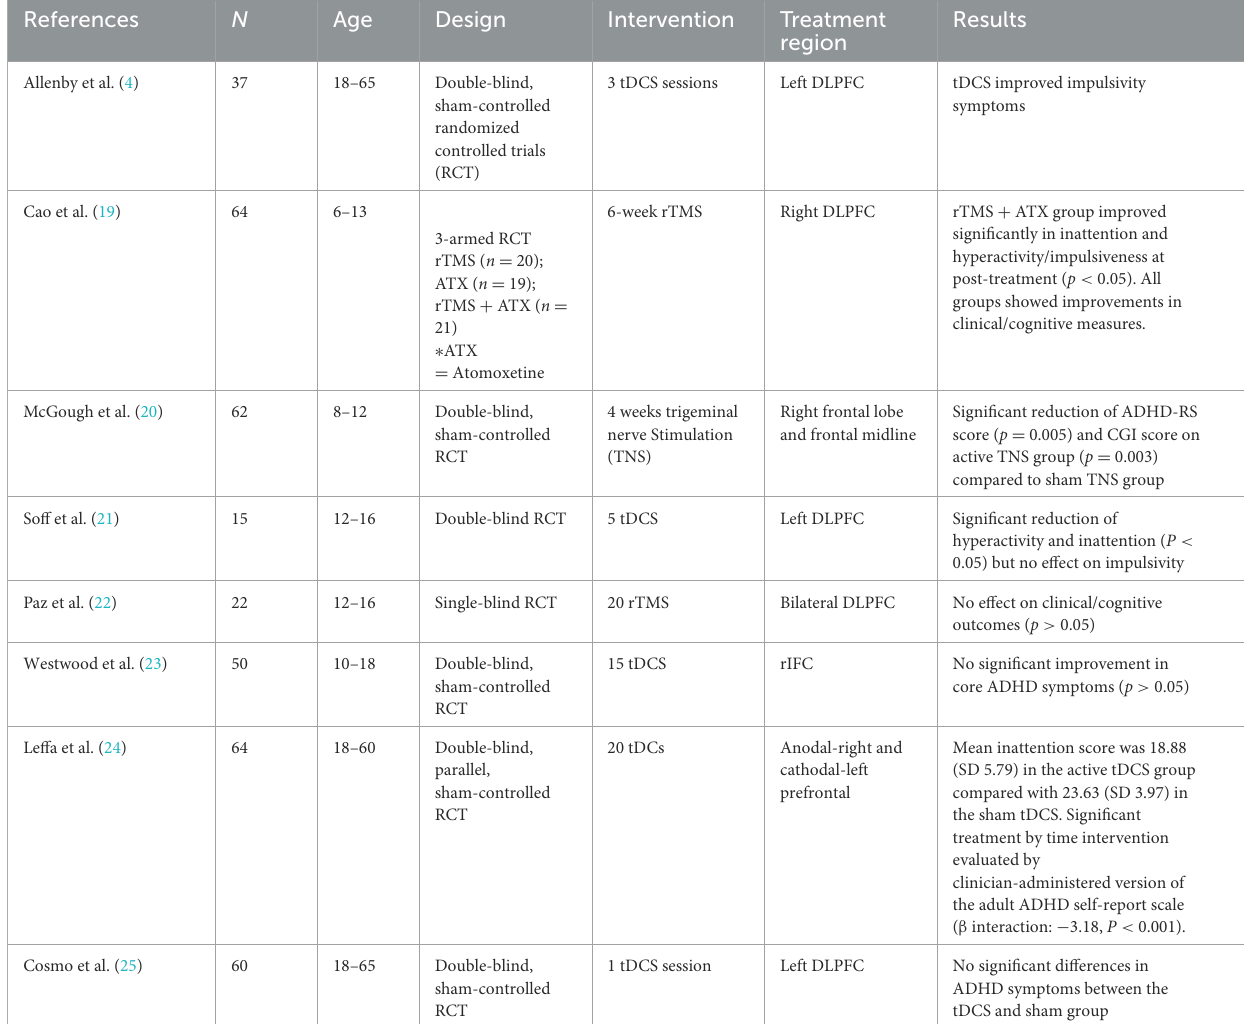
TABLE 1 Findings of non-invasive brain stimulation (NIBS) studies on